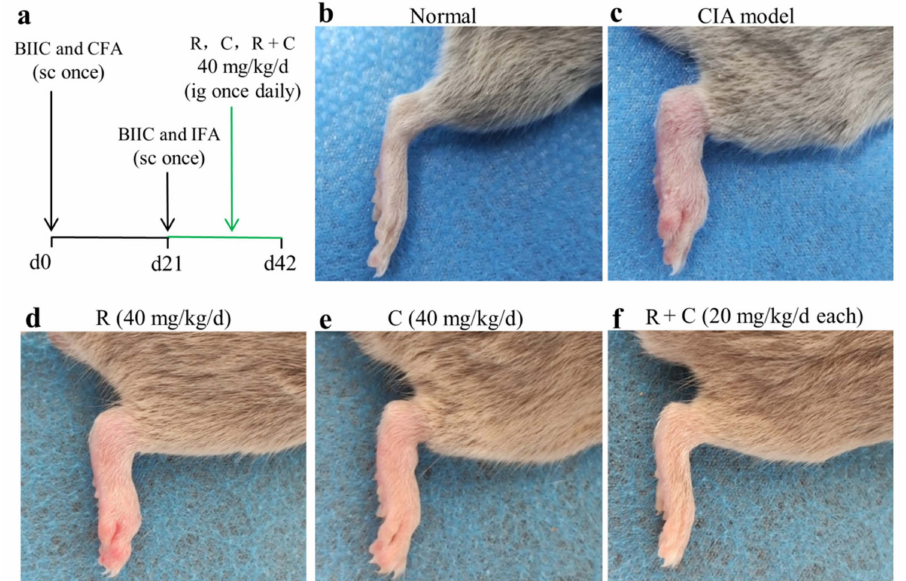
Figure 2. Rosmanol, carnosol, and their combination alleviated RA severity in CIA mice. Schematic of establishment of CIA DBA/1 mouse model and the treatments of rosmanol (R), carnosol (C), and their combination (R + C) in the CIA mice ( a ). Representative pictures from the right hind limbs of the normal group ( b ), model group ( c ), rosmanol-treated group ( d ), carnosol-treated group ( e ), and combination-treated group ( f ) on day